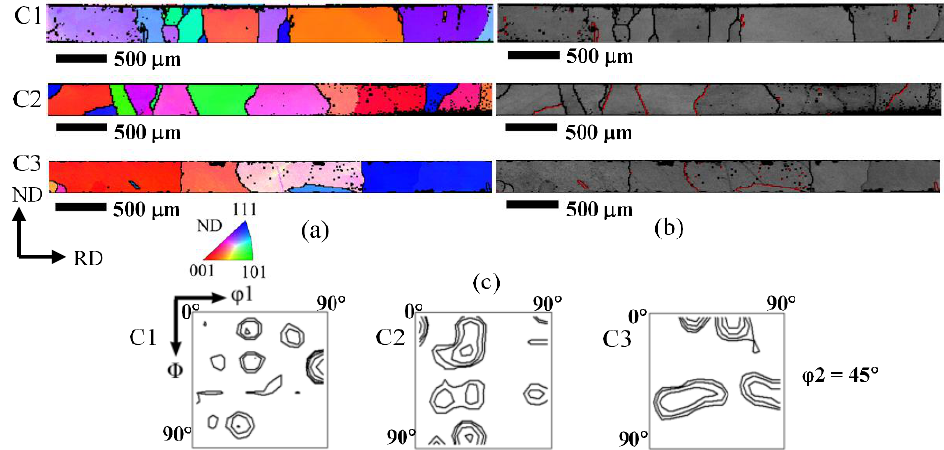
Figure 12. EBSD maps of 1# sheets after final transformation treatment under three conditions C1 to C3 of cold rolled 0.35 mm sheets from initial hot-rolled plates. ( a ) IPF-ND maps; ( b ) band contrast maps (red lines: Σ3); ( c ) ODFs at ϕ 2 = 45° section.